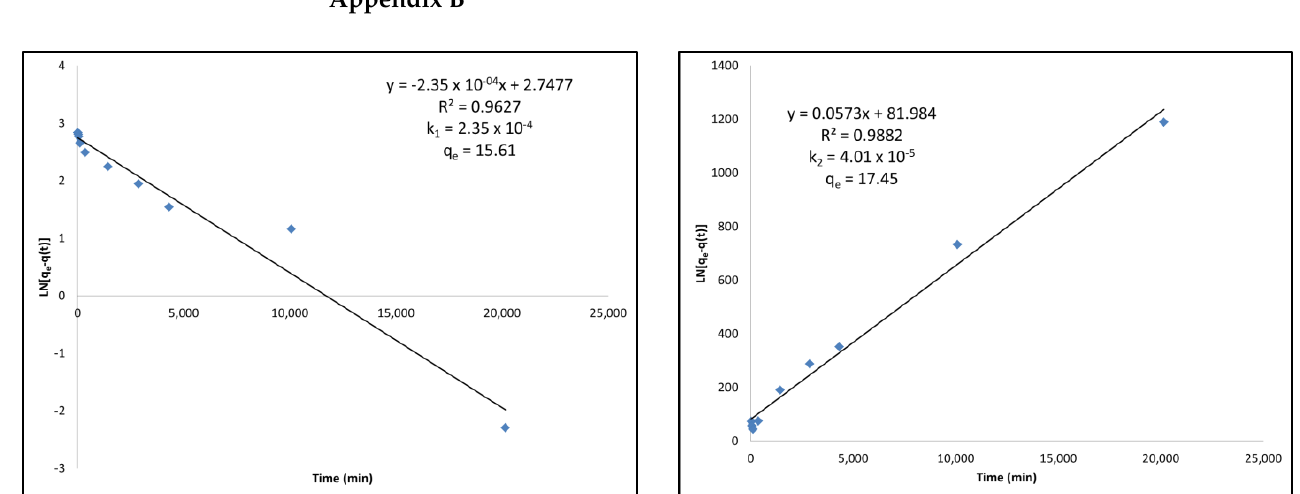
Figure A1. ( Left ) Pseudo-first-order kinetic modeling of standard activated carbon under Langmuir adsorption kinetics equations. ( Right ) Pseudo-second-order kinetic modeling of standard activated carbon under Langmuir adsorption kinetics equations.